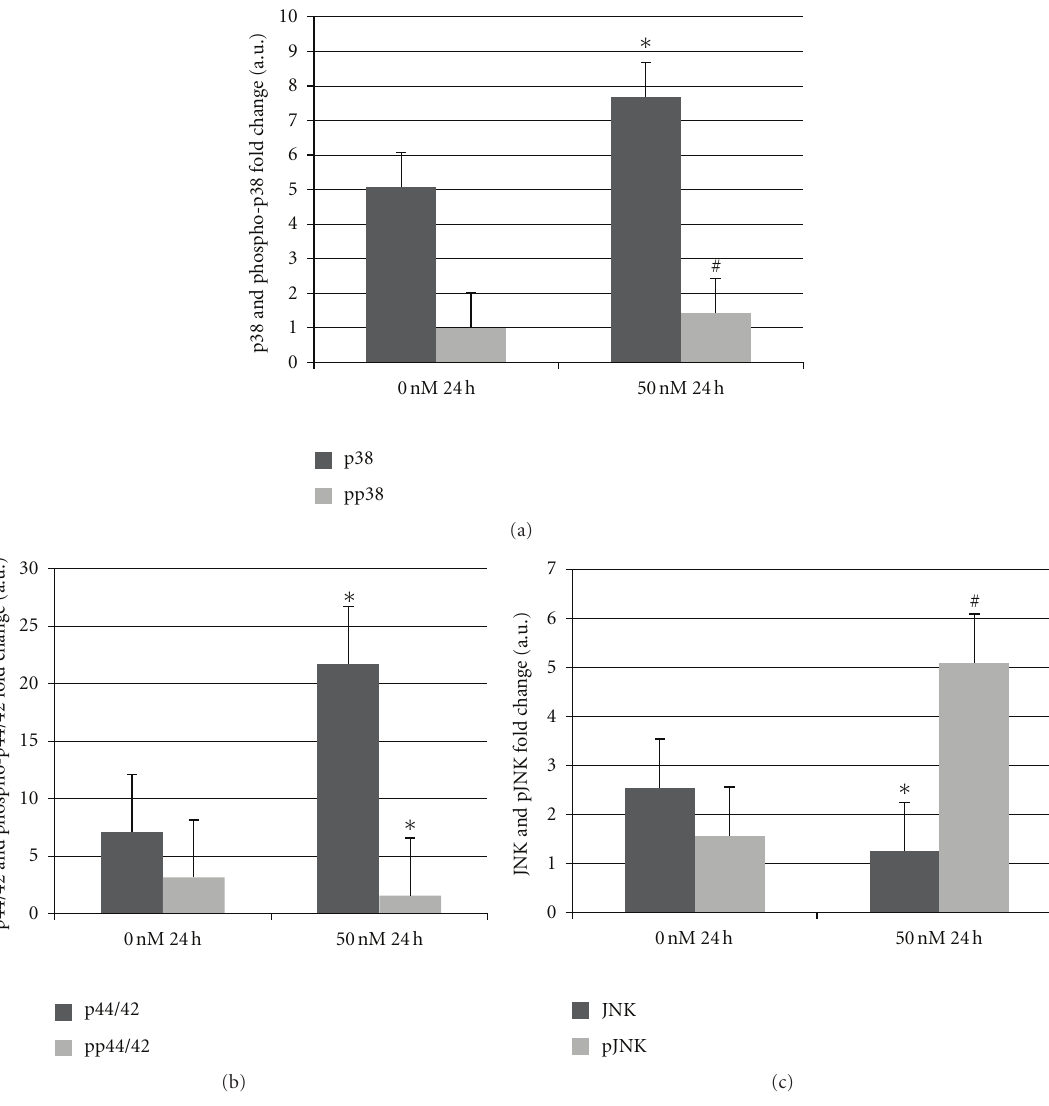
Figure 3: (a–c): C2C12 cells were di ff erentiated from myoblasts to myotubes as described in Section 2. Myotubes were transfected at each concentration of siRNA (SI00906220) (0 and 50nM) and collected at the designated time point (24h). Proteins were collected from these samples and subjected to immunoblot analysis. Data shown are representative of multiple independent experiments ( n = 2 to 4), all analyzed in triplicate ( ∗ P < 0 . 05, # P < 0 .